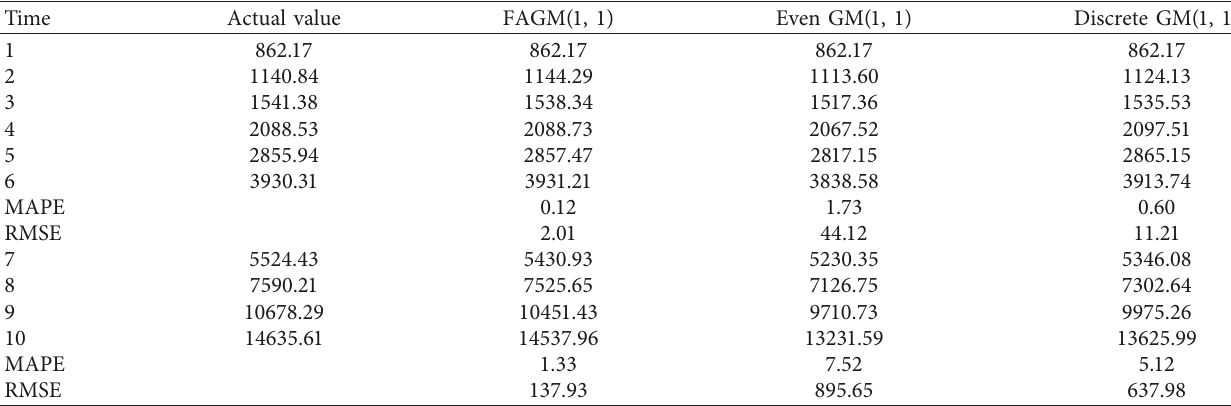
Table 3: The results of three models: Case 2.